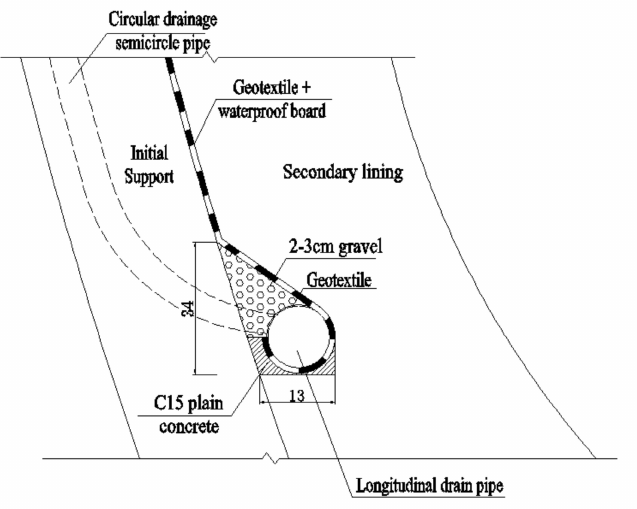
Figure 14. Schematic diagram of the connection between the circumferential drain pipe and longitu- dinal drain pipe (unit: cm in the figure).